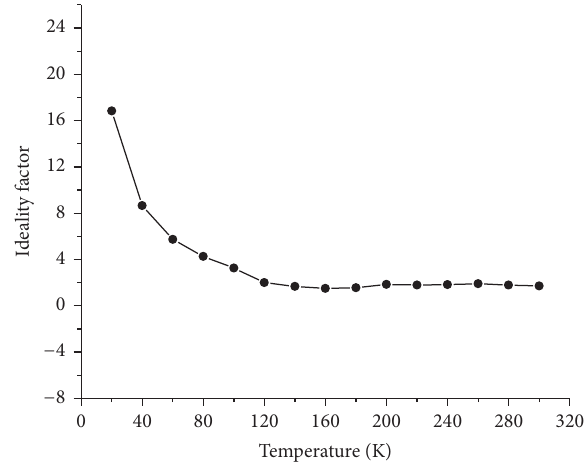
Figure 4: Plot of the 𝑛 value versus